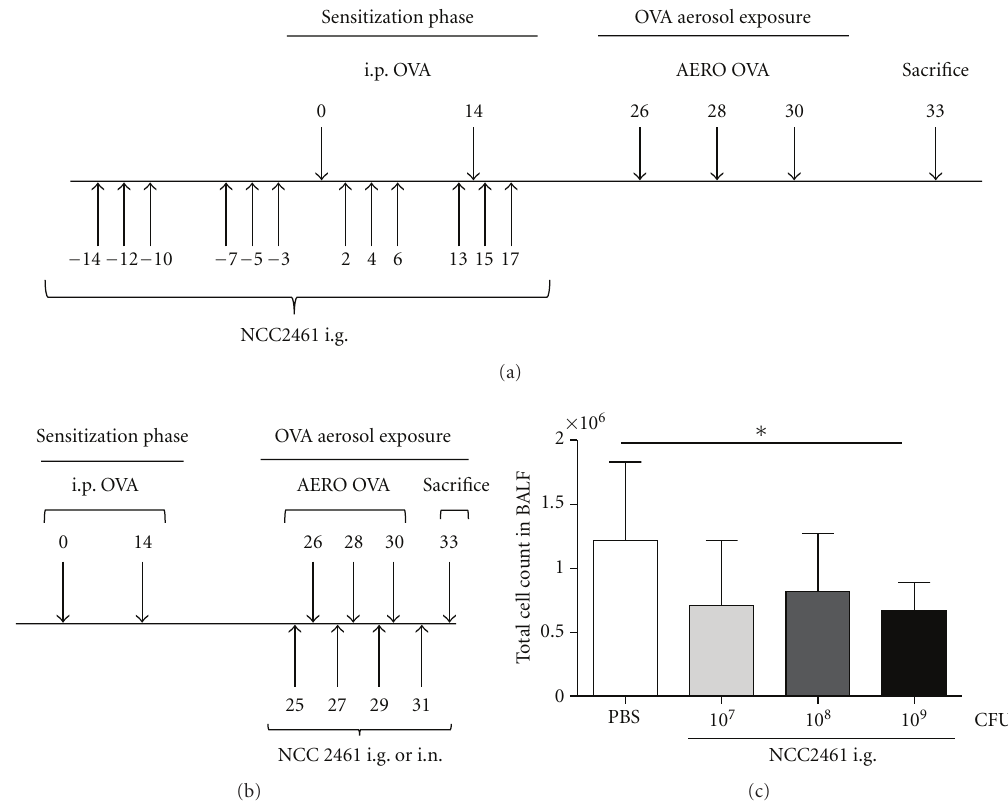
Figure 1: Protocols of probiotic strains administration and subsequent e ff ect of intragastric L. paracasei NCC2461 on total cell number in BALF of OVA-challenged mice. Mice were sensitized intraperitoneally (i.p.) twice with OVA and subsequently challenged with OVA aerosol 3 times. Mice received NCC2461 intragastrically (i.g.) 12 times before, after, and in between the 2 i.p. sensitizations (a) or 4 times before, after and in between each OVA challenge (b). Total cell count in the BALF ( n = 10) mice per group. In this representative experiment, data are expressed as mean ± SD; ∗ P < 0 . 05